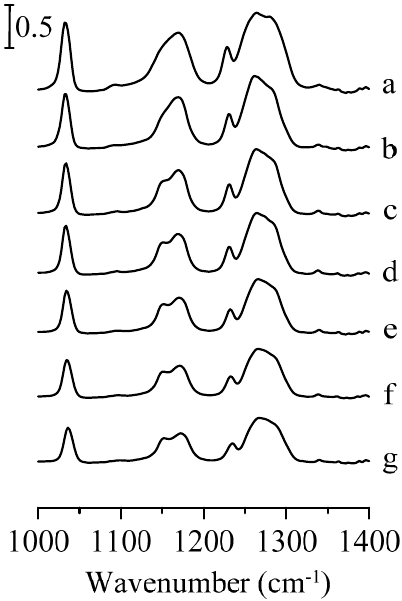
Figure 7. Infrared spectra of pure 1-ethyl-3-methylimidazolium trifluoromethanesulfonate obtained under ambient pressure (curve a) and at 0.4 (curve b), 0.7 (curve c), 1.1 (curve d), 1.5 (curve e), 1.8 (curve f), and 2.5 GPa (curve g).